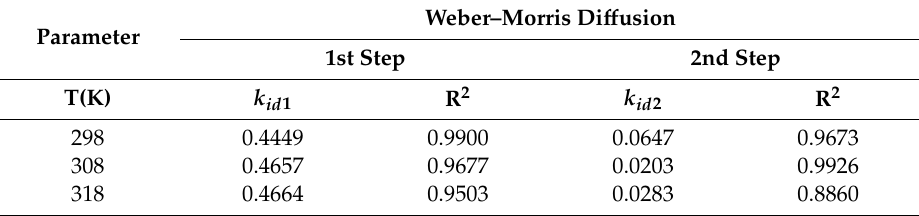
Figure 5. E ff ect of di ff erent temperatures on As(V) adsorption. ( a ) E ff ect of the temperature on the As(V) Figure 5. Effect of different temperatures on As(V) adsorption. ( a ) Effect of the temperature on the removal rate as a function of time. ( b ) Intraparticle di ff usion model fit for the As(V) removal by As(V) removal rate as a function of time. ( b ) Intraparticle diffusion model fit for the As(V) removal NZVI / AC at di ff erent temperatures (conditions: C 0 = 2.0 mg / L, pH = 6.5, 150 rpm, 20 × 40 mesh particle by NZVI/AC at different temperatures (conditions: C 0 = 2.0 mg/L, pH = 6.5, 150 rpm, 20 × 40 mesh size, adsorbent dosage = 1.5 g / L, t = 72 h, T = 298, 308, 318 K). particle size, adsorbent dosage = 1.5 g/L, t = 72 h, T = 298, 308, 318 K). Table 5. Rate constants for the kinetic model of As(V) adsorption on NZVI / AC at di ff erent temperatures.